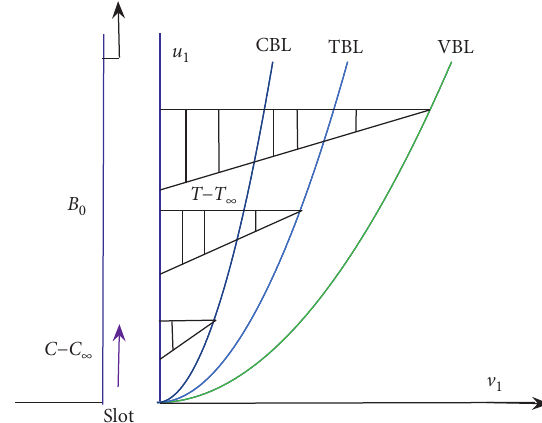
Figure 1: Schematic representation of Maxwell fluid